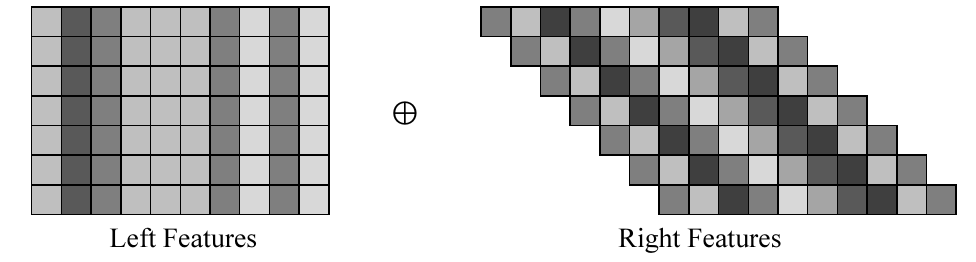
Figure 2. Cost volume in the GC-Net. ⊕ represents a concatenate operation.